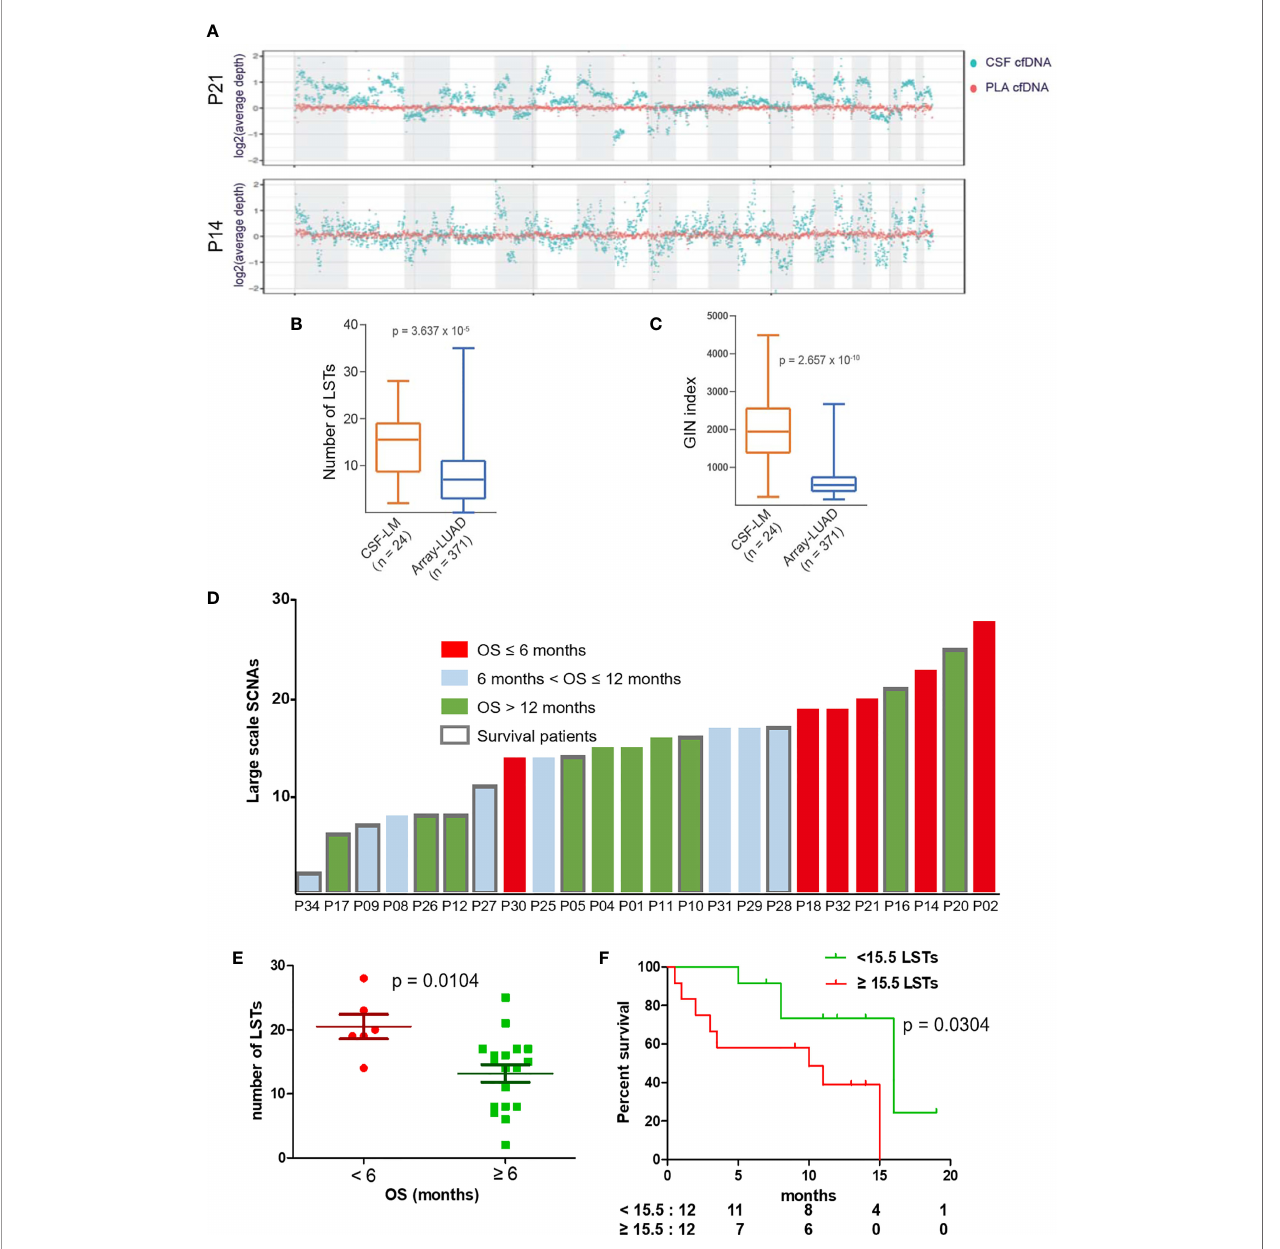
FIGURE 5 | LST as a potential prognostic marker for LM. (A) Visualization of genomic instability. The average depths along chromosomes (1M/bin) of CSF cfDNA (teal color) and matched plasma cfDNA (orange color) from 2 representative patients are shown. Plasma samples demonstrated a constant read across the chromosome, while reads from CSF samples varied continuously, indicating extensively affected copy numbers through the whole genome. (B, C) Genomic instability was assessed based on the number of large stable transitions [large-scale state transitions (LSTs)] and genome instability number (GIN) using low-coverage WGS data for the current cohort (n = 24, CSF-LM) and compared with a published dataset comprising genomic DNA pro fi les from primary lung adenocarcinoma tissues [n = 371, Array-LUAD (24)]. Data were analyzed as described in the Materials and Methods . (B) Comparison of LST between CSF-LM and Array-LUAD. The average level of LSTs in CSF-LM was signi fi cantly higher than that in Array-LUAD (15.0 vs. 7.8, p < 0.001). (C) Comparison of GIN levels between CSF-LM and Array-LUAD. The average level of GIN in CSF-LM was signi fi cantly higher than that from Array-LUAD (1,961.4 vs. 681.6, p < 0.001). (D) Levels of LSTs and survival status in LM patients (n = 24). Each column represented each patient. Columns in red indicate an overall survival of less than 6 months, columns in green indicate an overall survival of over 12 months, columns in gray indicate an overall survival between 6 and 12 months. The columns with borders indicate the patients who were still alive at the time of the data collection and reporting, while the columns without borders indicate patients who had died at the time of data collection. (E, F) Association of LSTs with survival. (E) The levels of LSTs were signi fi cantly lower in patients whose survival was over 6 months (p = 0.0068). (F) Kaplan – Meier curves of overall survival. With a cutoff at 15.5, the median level of this cohort, patients with higher levels of LSTs demonstrated a short survival (median OS after LM, 10 months vs. 15 months, p = 0.038). However, GIN was not associated with survival ( Figure S1